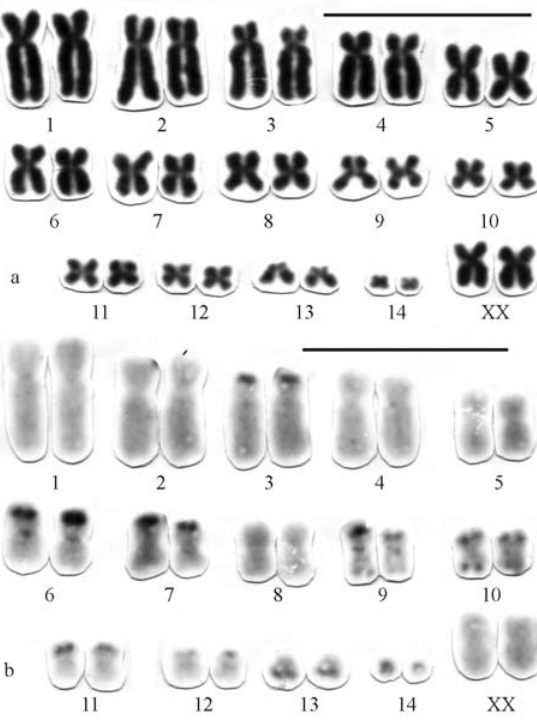
Figure5 -KaryomorphCwith2n=28,FN=50of P.longicaudatus from Parque Nacional das Emas (GO): a) Karyotype conventionally stained; b) C-banding pattern. Bar = 10 (cid:1) m.